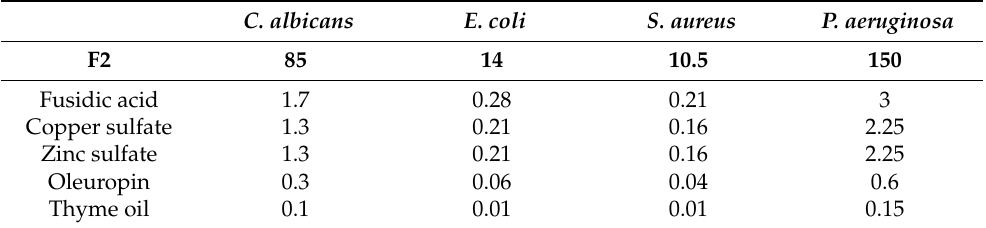
Table 6. MICs of the F2 formula and active ingredients alone against the selected pathogens.